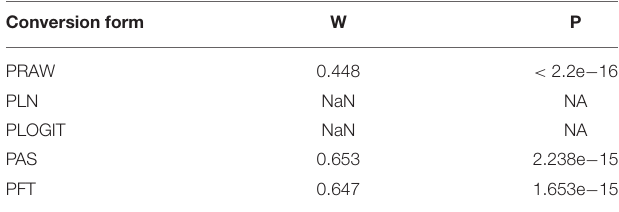
TABLE 1 | Normal distribution test of the original rates and the different transformations of the original